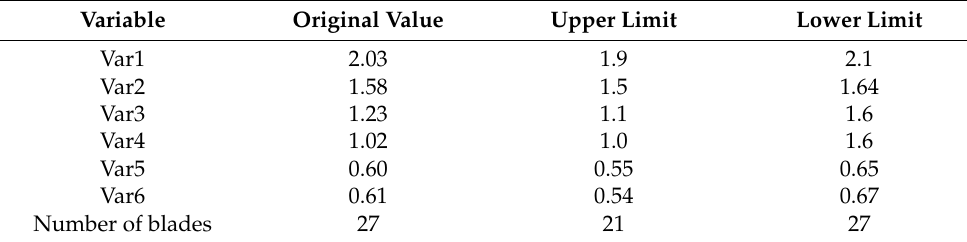
Figure 3. Optimization variable definitions and variation ranges: ( a ) solidity; ( b ) maximum thickness position. Table 2. Original parameter values and variation